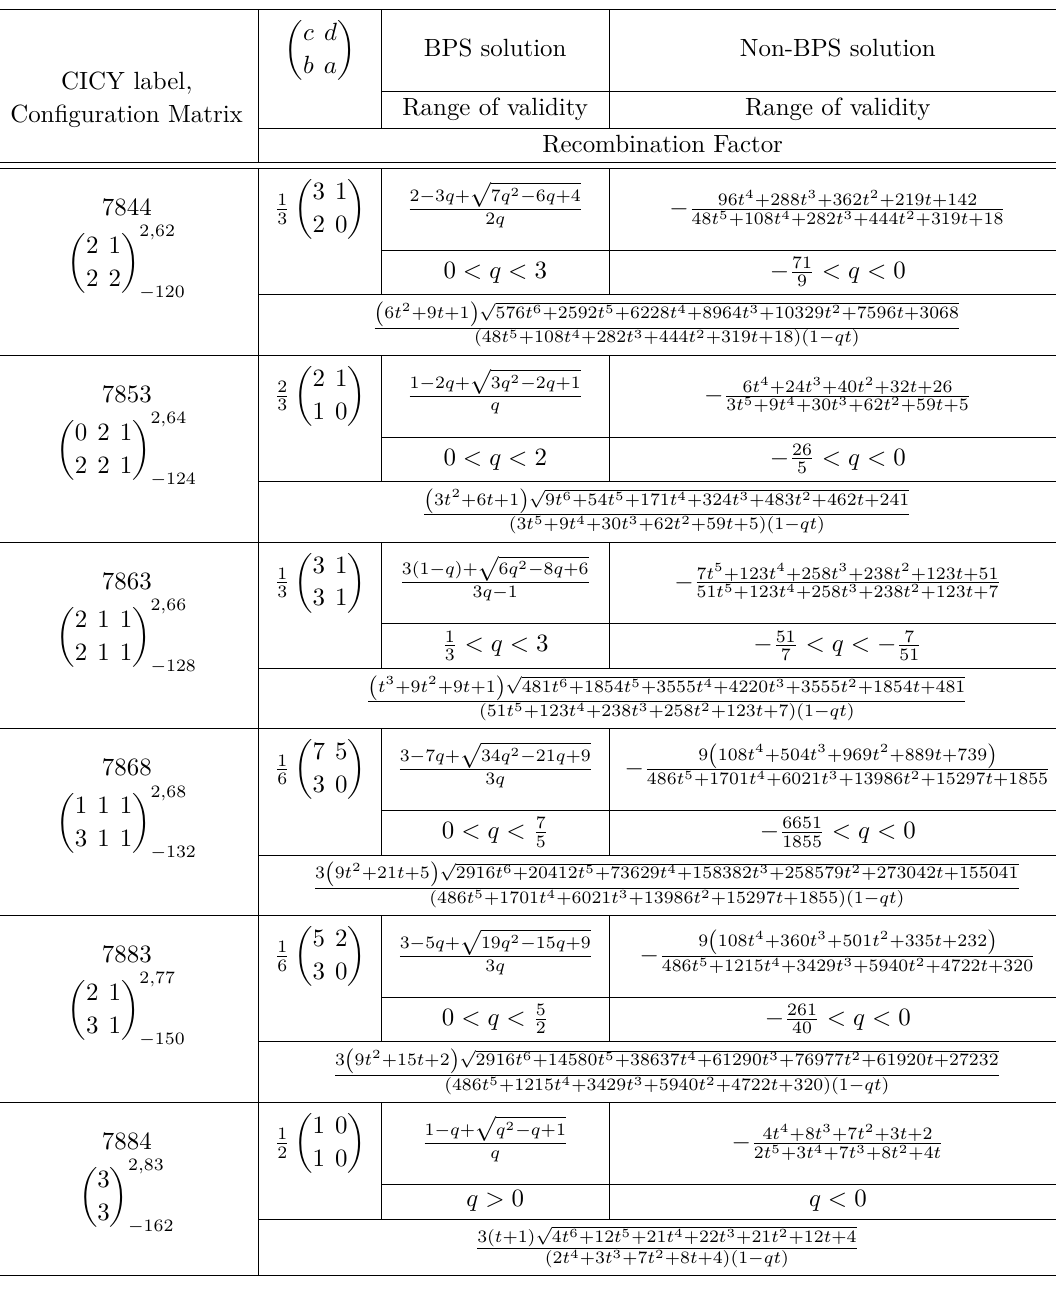
Table 3 . BPS and non-BPS extremal black holes in one-modulus CICY models,